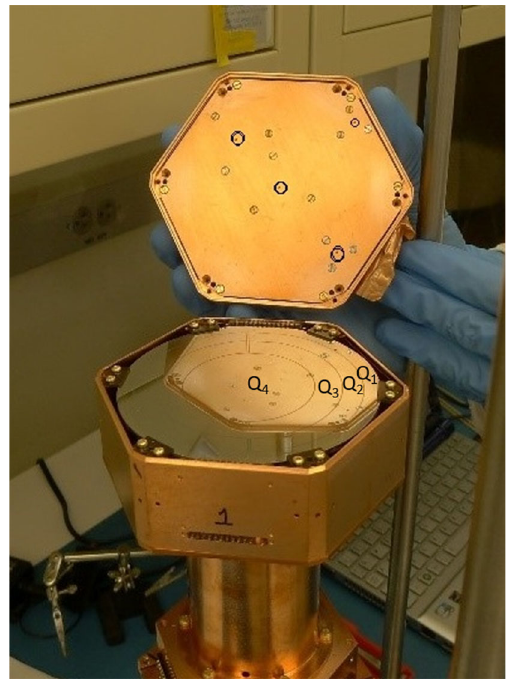
Fig. 2 Shown is the detector studied in this work with four electrodes read-out ( Q 1 , Q 2 , Q 3 , andQ 4 ). Four 241 Am sources were arranged in such a way that one source was over each channel. The opposite side of the detector is grounded with uniform Al electrodes so that the electric field points along the z-axis of the crystal. The size of the detector is 10cm in diameter and 3.3cm in thickness with a mass of ∼ 1.4kg